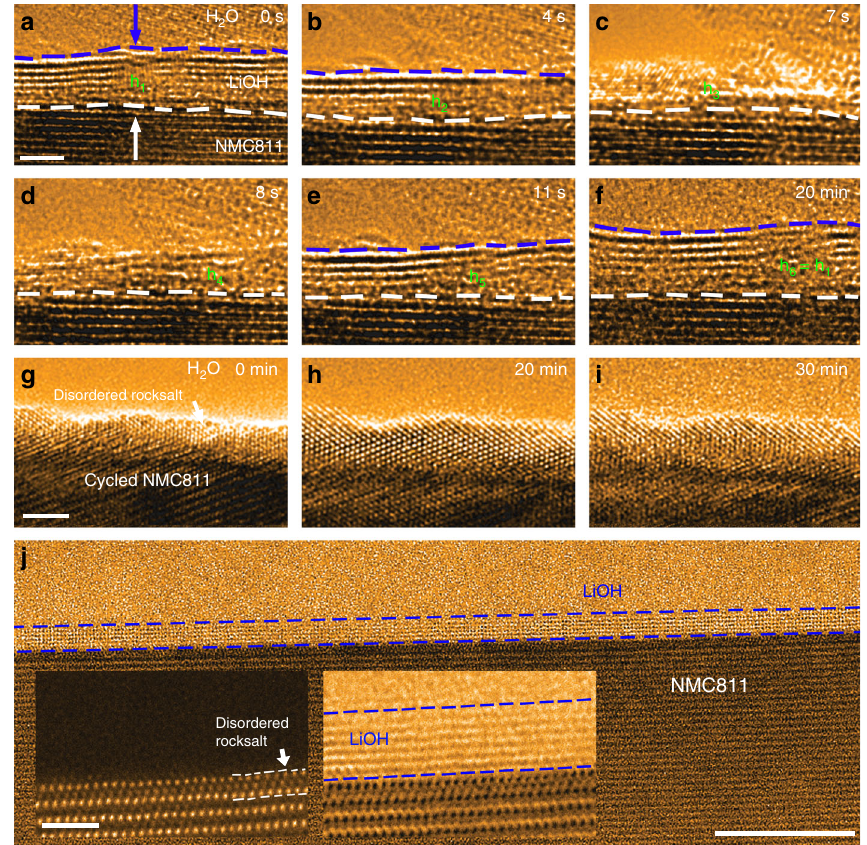
Fig. 5 Self-healing and disordered rocksalt resultant passivation. All the TEM sequences are captured under the continuous exposure to water vapor with a pressure of P H2O = 5 × 10 − 2 Torr and at room temperature. a Pristine NMC811 covered with a saturated hydroxide fi lm after the water vapor exposure of 30 mins with the electron beam blanked. b , c The hydroxide thickness evolution with the condense of the electron beam. The saturated LiOH layer with a thickness of h1 is completely removed after 7 s. d – f The self-healing processes at the local breaches as the weakening of electron beam. The LiOH layer recovers to the characteristic thickness after a few seconds and maintains the thickness during the subsequent 20 mins. g – i The surface evolution of NMC811 with a disordered rock salt shell. The arrow points to the disordered phase developed upon cycling, no reaction products are formed during the 30 mins water vapor exposure. j ABF-STEM images of the NMC811 after being exposed to water vapor for 30 mins. The contour of LiOH is outlined by the blue dashed lines. The inserts in j are the HAADF-STEM (left) and the corresponding ABF-STEM image (right) showing the surface with half-unit-cell-thick disordered structure and the formation of saturated LiOH layers after the water vapor exposure. The white and blue dashed lines indicate the boundaries of disordered rocksalt structure and the LiOH layers. Scale bar, 3 nm a , 2 nm g , 10 nm j , 1 nm inserts of j